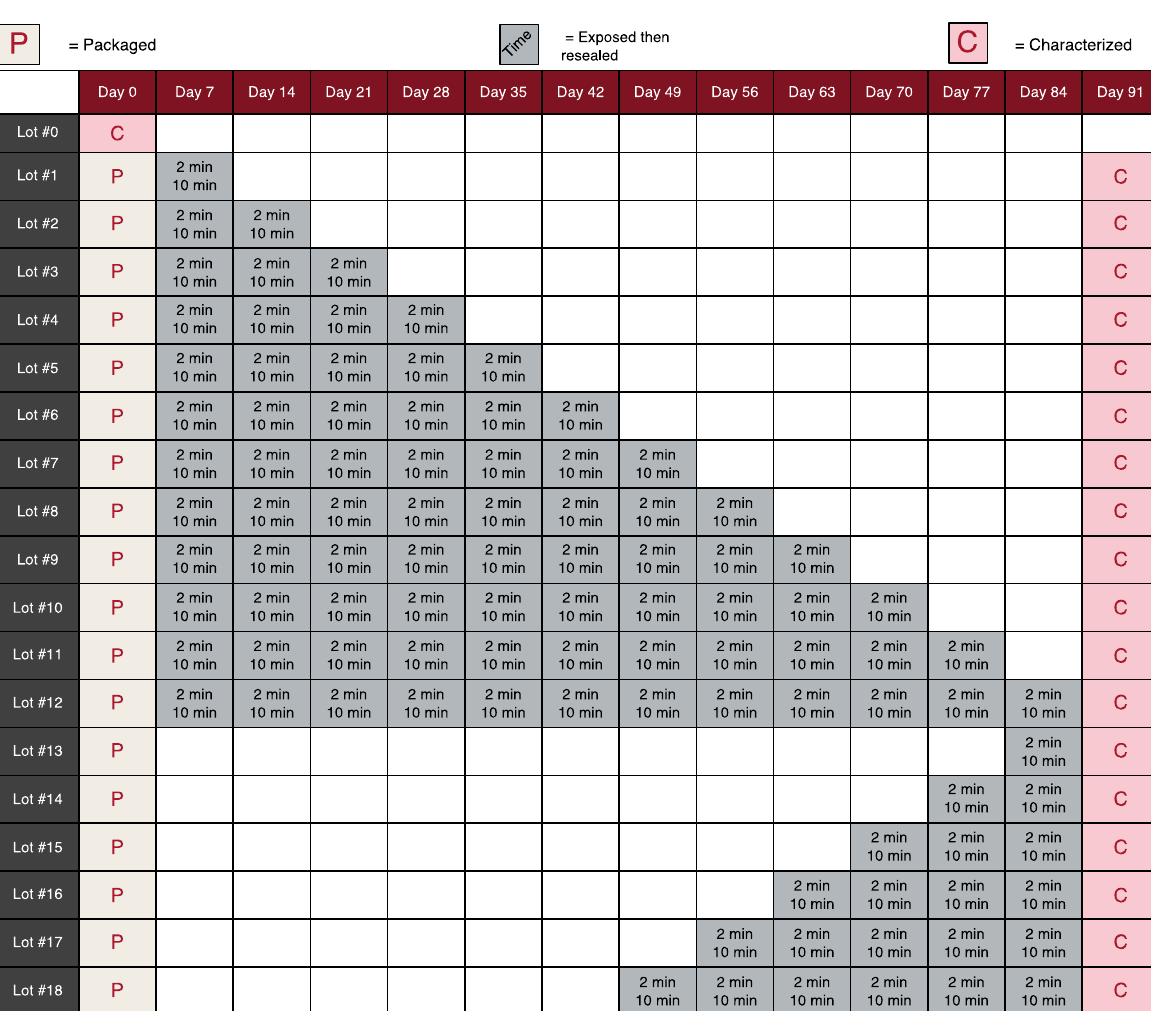
Figure 1. An experimental matrix of the packaging, exposure, and characterization of the Al 5056 and Ta powder samples in Lots #0 through #18 for the three-month study.